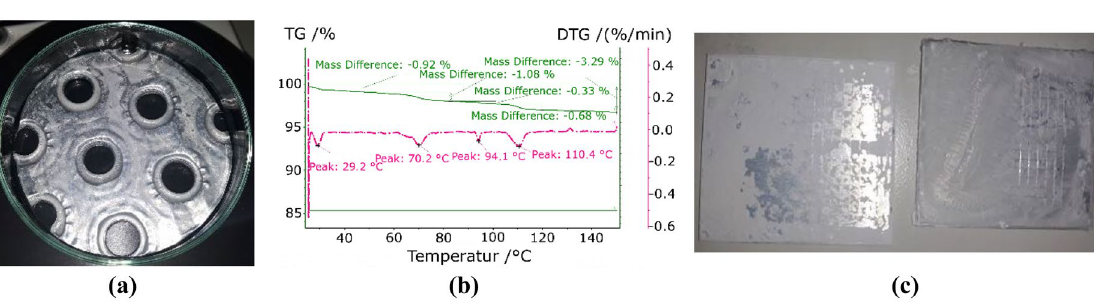
Figure 10. SrCl 2 coating with HEC: ( a ) fin, ( b ) TGA, ( c ) cross-cut test without (left) and with HEC